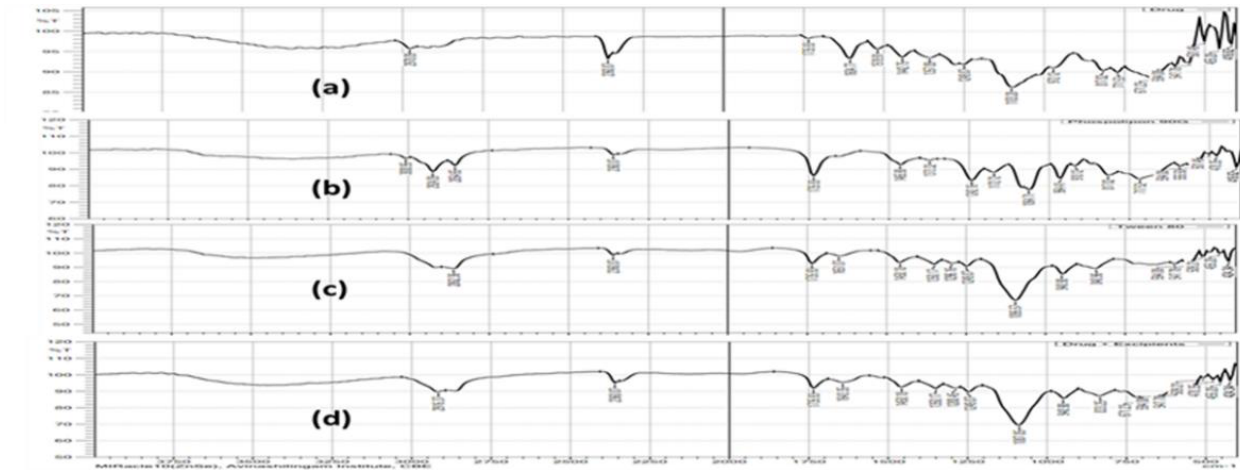
Figure 1. FTIR graphs for the drug polymer compatibility study: ( a ) pure PAC, ( b ) Tween 80, ( c ) phospholipid 90 G, and ( d ) optimized transferosomes-loaded proanthocyanidin .